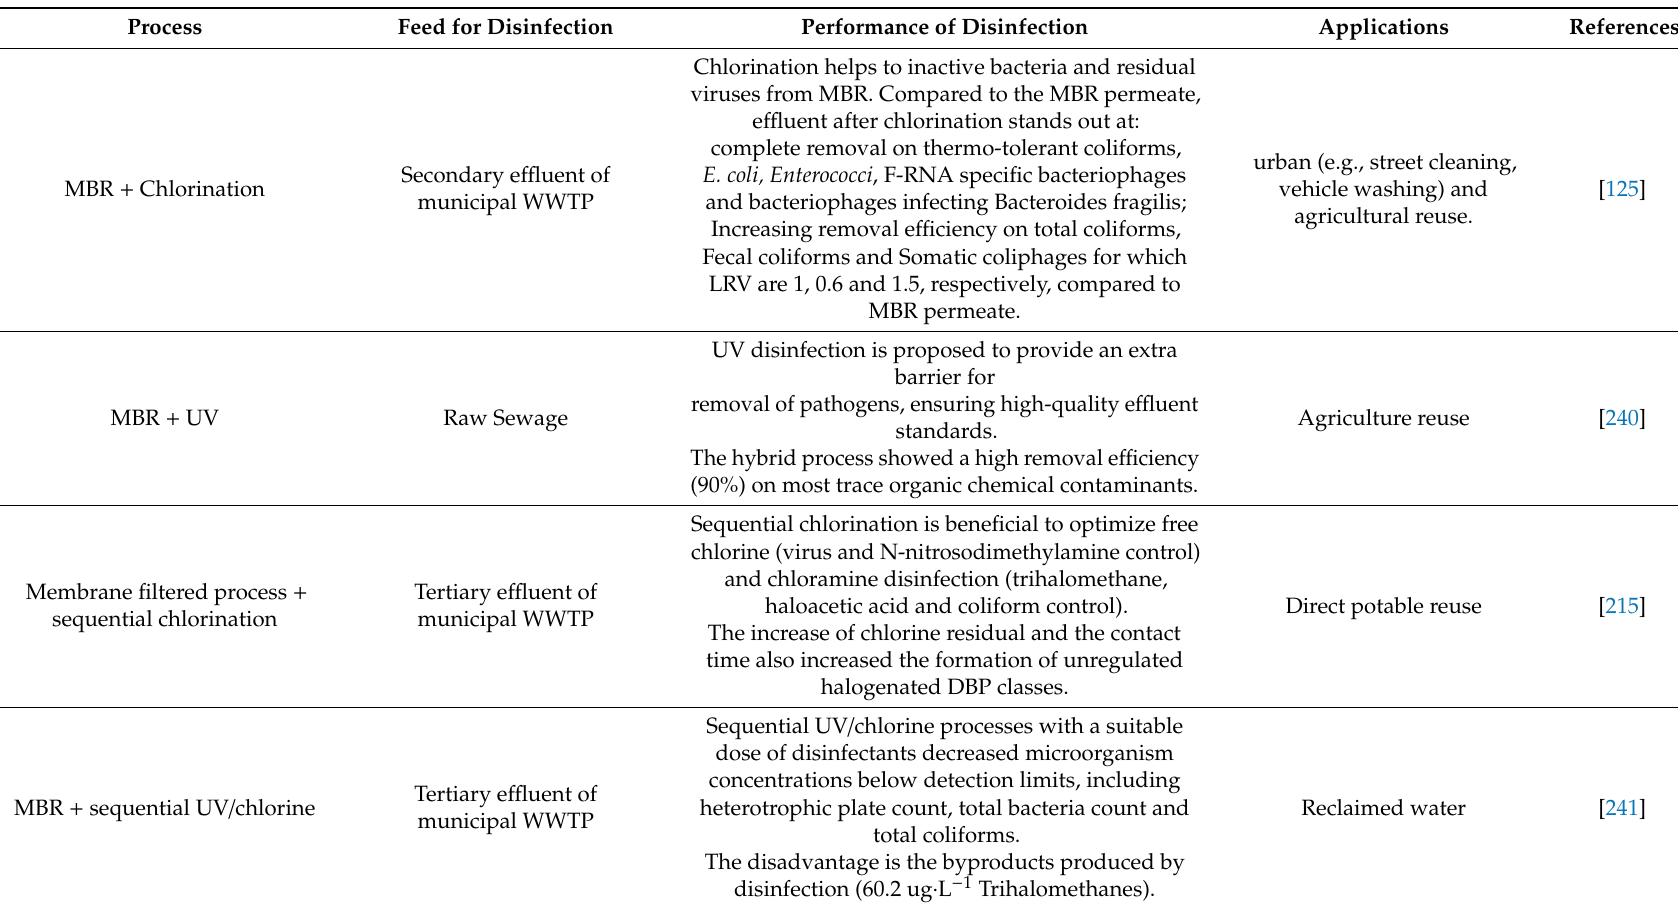
Table 11. Combination of membrane processes with disinfection processes for wastewater reuse